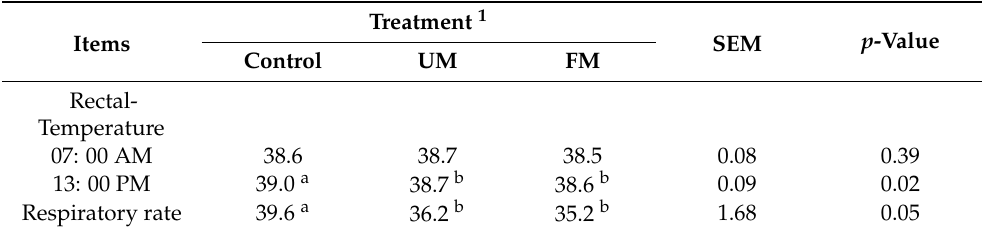
Table 1. Rectal temperature and respiratory rate of lactating cows fed the total mixed rations (TMR) containing unfermented (UM) and fermented (FM) yellow wine lees (YWL) mix.